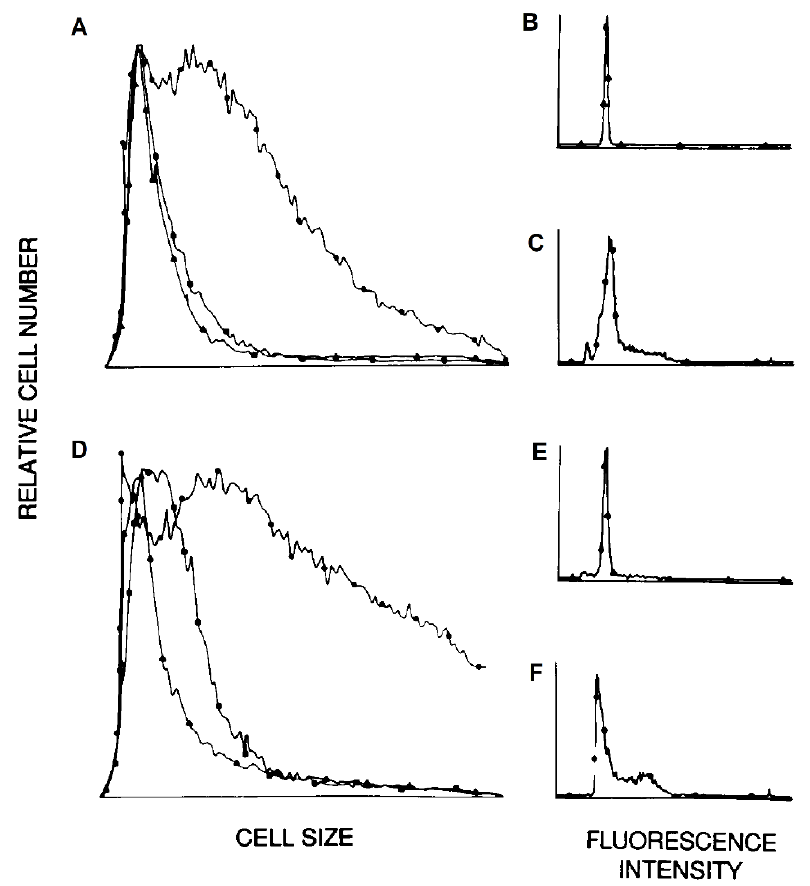
Figure 4. Cell size distributions ( A , D ) and cell cycle analyses ( B – F ) of human lymphocytes cultured for three days after stimulation with inactivated influenza virus in the presence of <0.5% ( A – C ) or 26% ( D – F ) monocytes-macrophages (see protocol in Figure S3). Cells were then exposed to infectious influenza virus and analyzed and separated by elutriation into fractions enriched for small ( ▲ in ( A , D )), resting ( B , E ) lymphocytes, and large ( , A , D ), proliferating ( C , F ) lymphocytes. The horizontal axes of A and D indicate linear increments in size from 0 to 1220 μ 3 . Intermediate results were obtained using lymphocytes cultured in the presence of 11% monocytes - macrophages. Intermediate fractions of lymphocytes from each monocyte - macrophage - lymphocyte coculture, obtained immediately after changing elutriator settings and containing substantial mixtures of resting and proliferating lymphocytes, were discarded without further analysis.